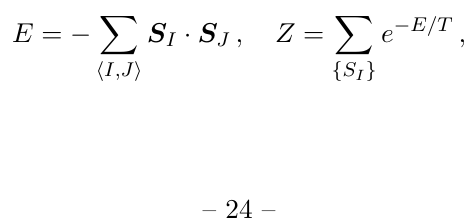
Figure 6 . A typical con(cid:12)guration in calculating the second R(cid:19)enyi mutual information. There are two replicas (left and right) and each one is divided into two regions two replicas are strongly correlated in the sense that an update of any spin in and only if the update a(cid:11)ects the same spin in both replicas. On the other hand, the updates in regions are independent in each B